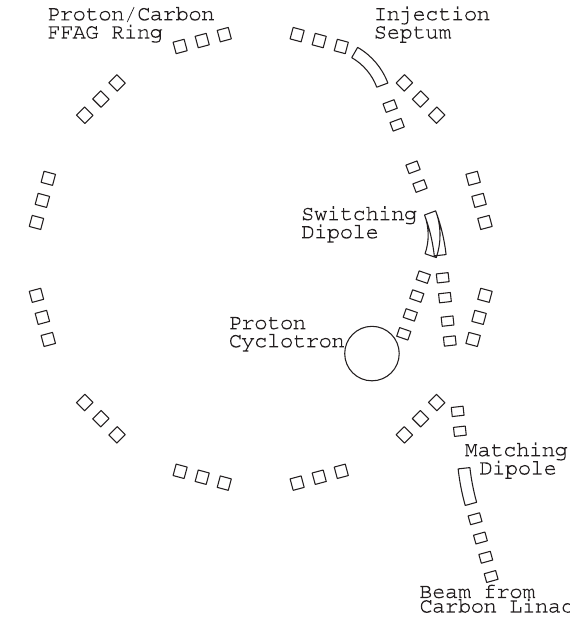
FIG. 31. MEBT injection layout for PAMELA, based on a cyclotron inside the FFAG ring.